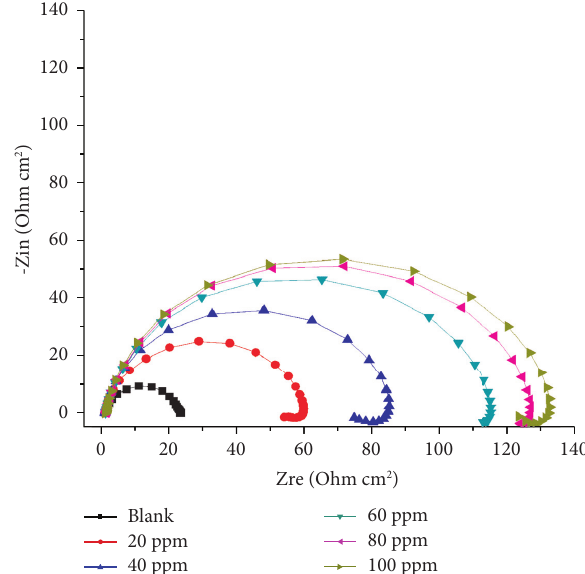
Figure 3: Nyquist diagrams of mild steel in corrosive media at 298K with AMP’s various concentrations.